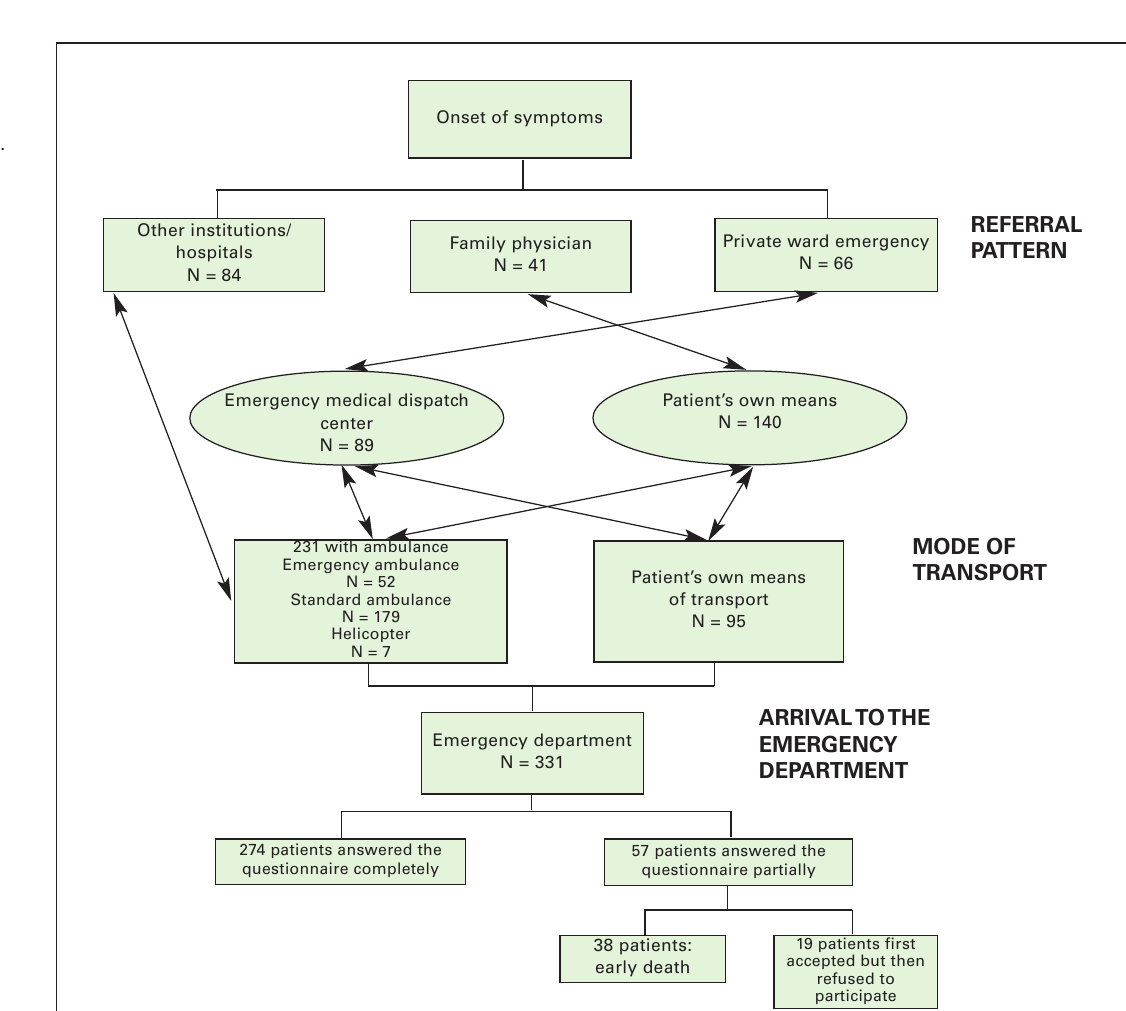
Figure 2 Flow-chart of the process between onset of symptoms and study inclusion.